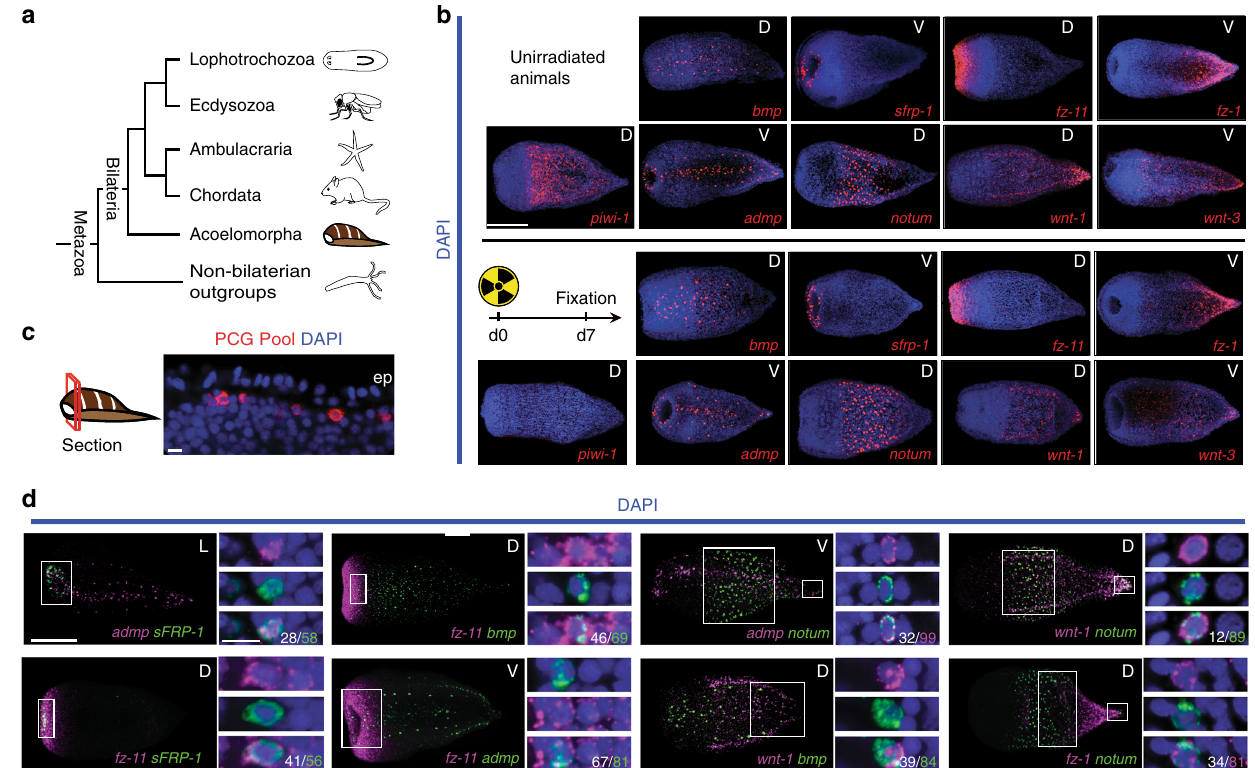
Fig. 1 PCGs are expressed in a common differentiated cell type. a A phylogenetic tree representing the relative position of acoels within the Metazoa. Phylogenetic analyses support the position of acoels as the sister group to other bilaterian lineages, diverging shortly after the origin of the Bilateria > 550 million years ago 17, 18, 20 . b As a marker for cycling cells, piwi-1 expression is sensitive to irradiation and is ablated by 7 days post-irradiation with 10,000 rads 17 . PCG expression domains 17 were maintained, suggesting that they are primarily expressed in non-cycling, differentiated cells. c Fluorescent image of a transverse optical section in the anterior. ep epidermis. PCG pool comprised of simultaneously hybridized sFRP-1, frizzled-11, bmp, admp, notum, wnt-1 , and frizzled-1 RNA probes. d Eighteen RNA probe pairs were used in double-FISH experiments. The denominator for each quanti fi cation is the total number of cells in the channel indicated (i.e., magenta or green); the numerator is the total number of double-positive cells for that pair. Quanti fi cation was performed in area indicated by the white box, and inset panels below are higher magni fi cation images of cells for this region. See Supplementary Fig. 1b for remaining pairs. Scale bars: b 100 μ m; c 10 μ m; d 100 μ m, overview image; 10 μ m, cell inset. D dorsal view, V ventral view, L lateral view. Overview images